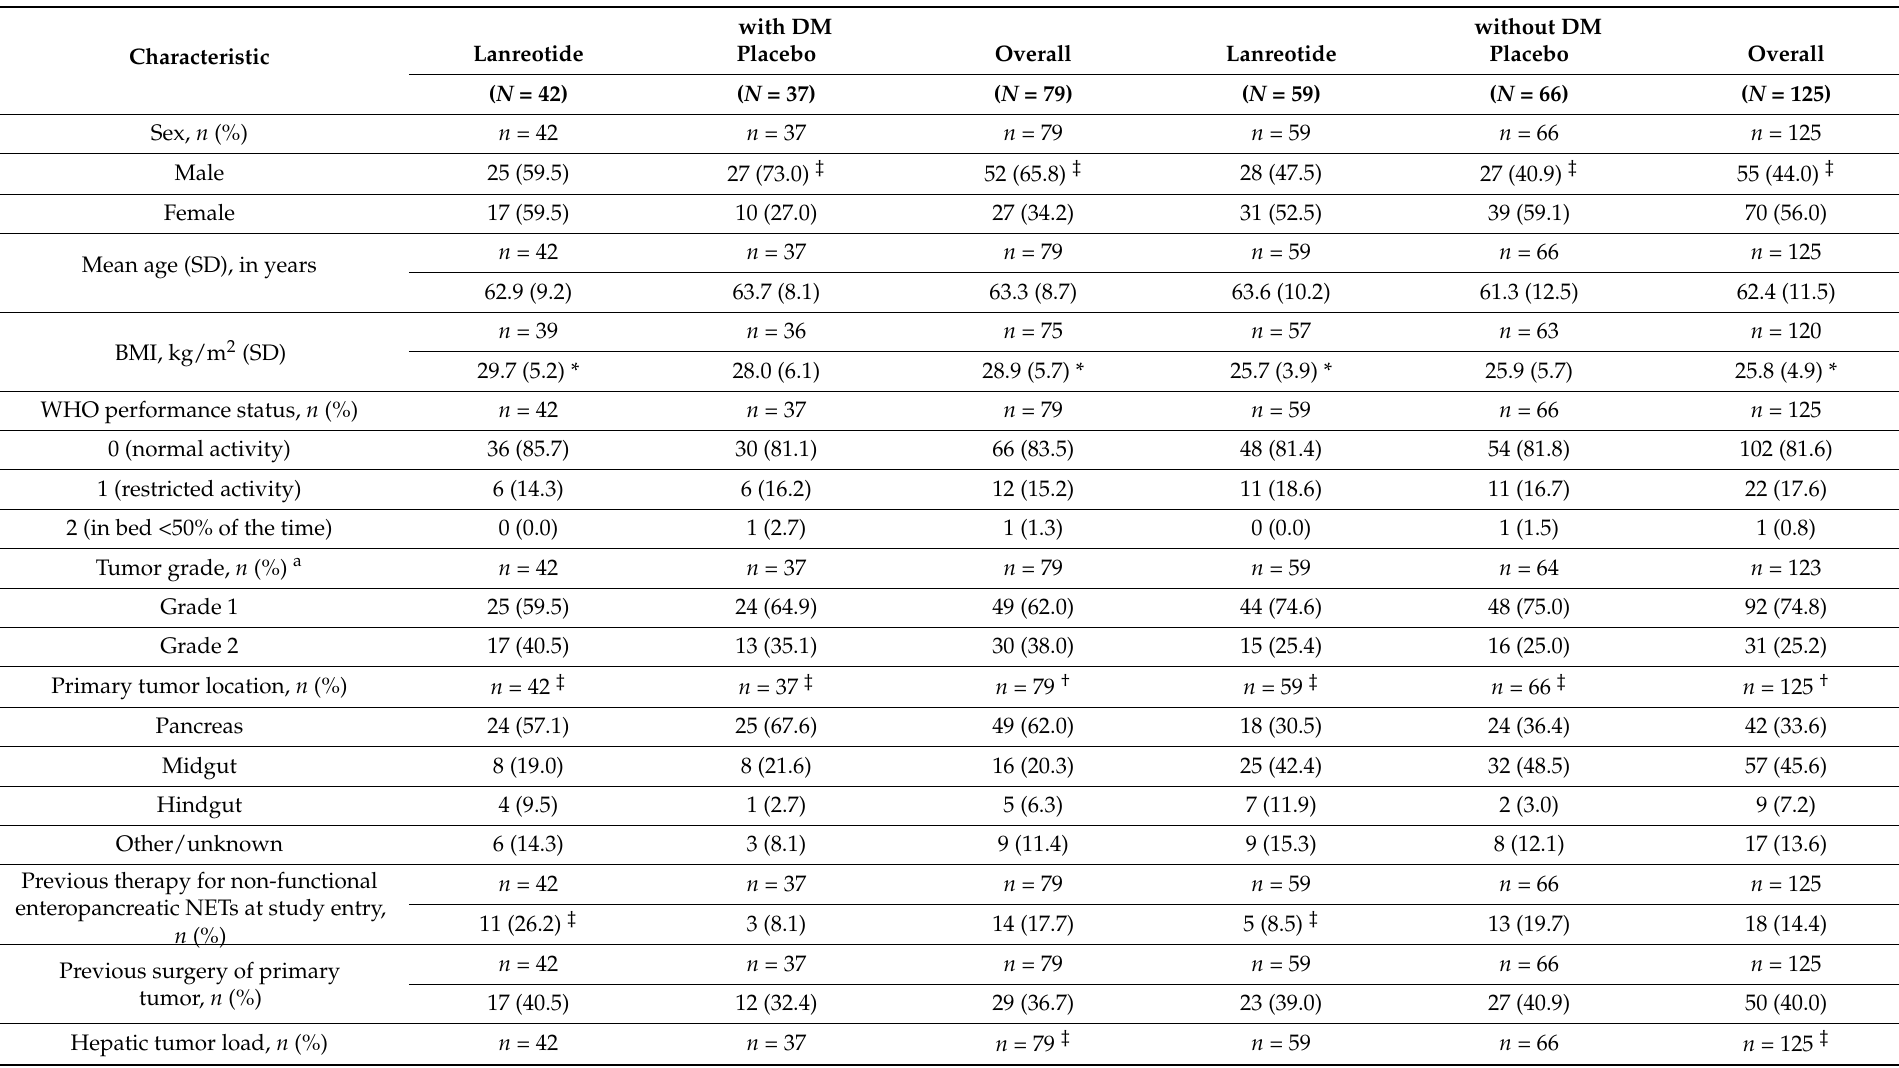
Table 1. Baseline characteristics by DM status (intention-to-treat